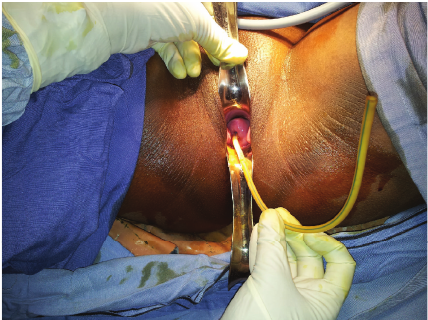
Figure 1: Per speculum examination showing the foreign body protruding out of the cervix.